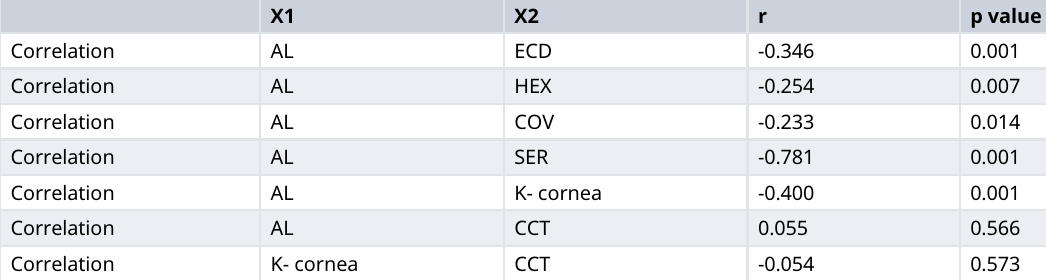
Table 4. Relationship between AL and CEC (corneal endothelial cell)